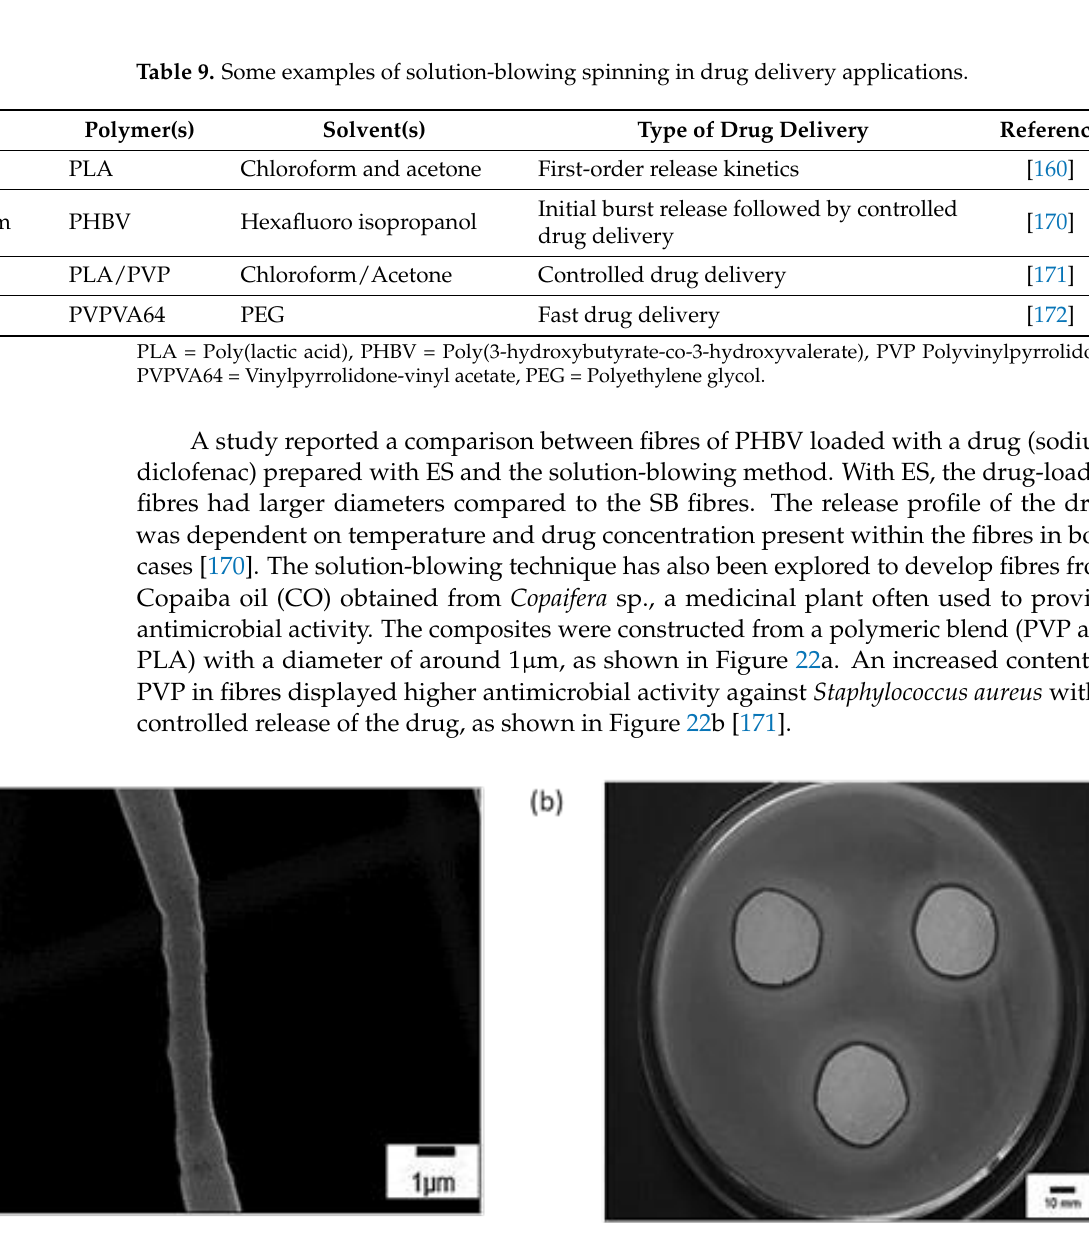
Figure 22. SEM image ( a ) of Fibres containing PVP and PLA blend with 20-CO ( b ) In vitro antimi- crobial activity of PLA/PVP 20-CO sample against Staphylococcus aureus. Reproduced with per- mission from [171], copyright 2015 Elsevier. Table 9. Some examples of solution-blowing spinning in drug delivery